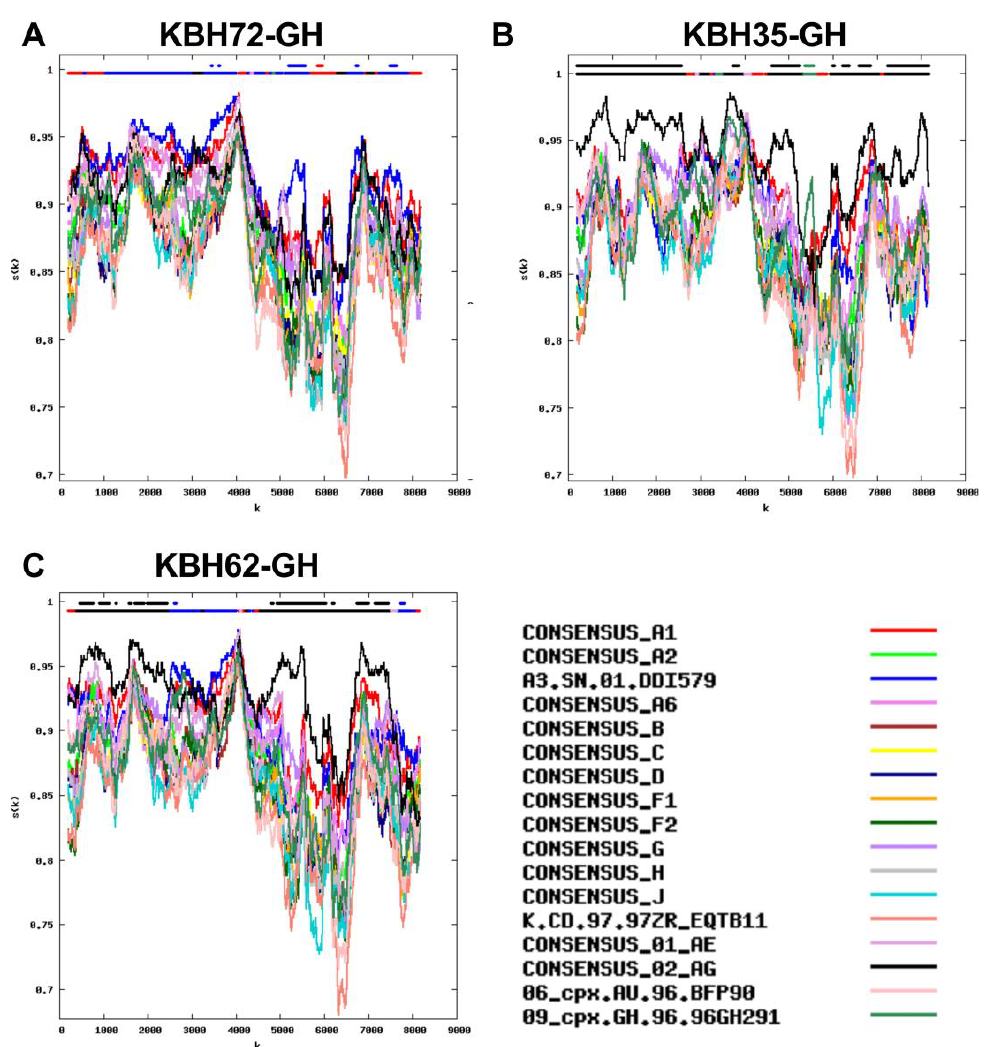
Figure 7. Full-genome similarity plots of unique recombinants. Panels ( A – C ): The y-axis denotes the % similarity between the participant sequence to each of 17 reference sequences (each in a different color) over a sliding window of 400 bases (shown on X axis). The bars at the top of each plot indicate the best matching reference sequence over a given sequence region (lower bar) and whether this match meets the 95% confidence threshold (upper bar). Panel ( A ) Novel A3 and A1 recombinant in KBH72-GH. Panel ( B ) Novel recombinant containing CRF02_AG and 09_cpx in KBH35-GH. Panel ( C ) Novel recombinant of CRF02_AG and A3 in KBH62-GH.